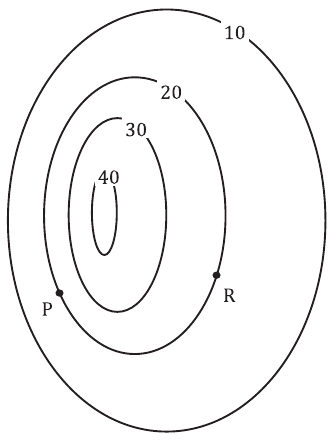
FIG. 1. A topographical contour map representing an overhead view of a hill. The lines represent locations of equal height, from 10 to 40 m. (Diagram adapted from the Open Source Tutorials in Physics Sensemaking